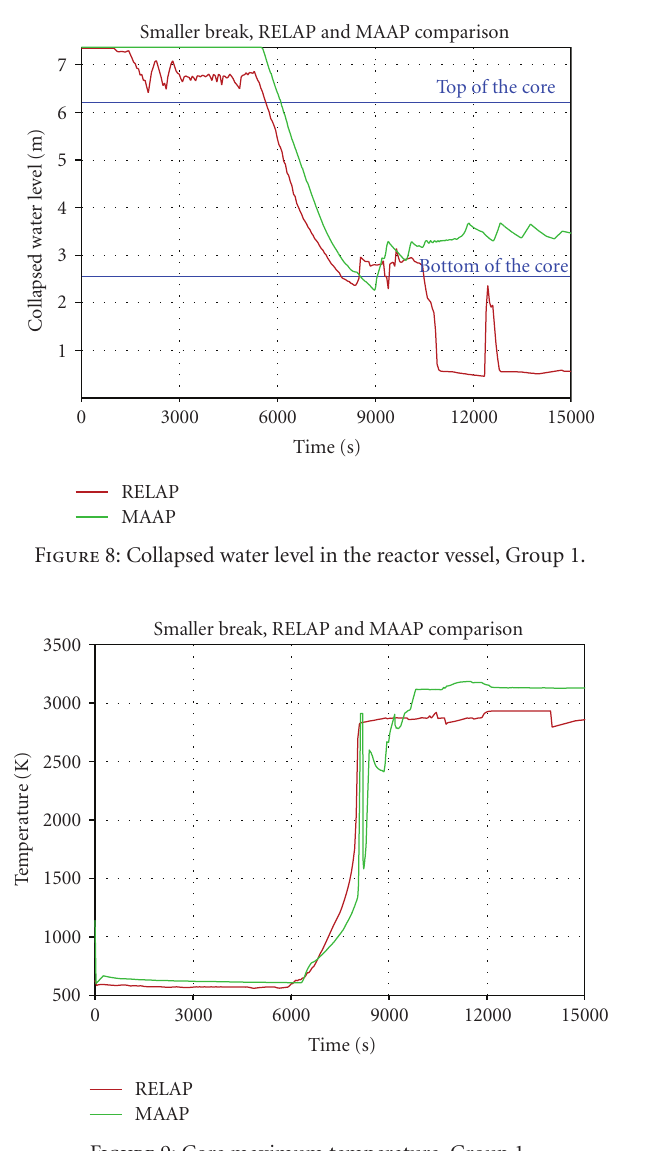
Figure 9: Core maximum temperature, Group 1.